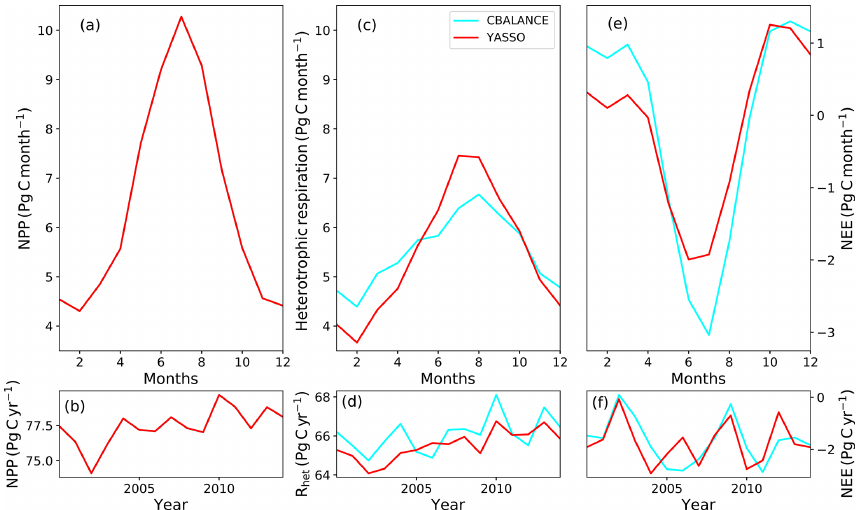
Figure 2. The annual cycles of net primary production (NPP) (a) , heterotrophic respiration (c) and net ecosystem exchange (NEE) (e) globally from the CBALANCE (in cyan) and Yasso (in red) model versions. In the sub-panels, annual values are plotted for 2000–2014 for NPP (b) , heterotrophic respiration (d) and NEE (f) .